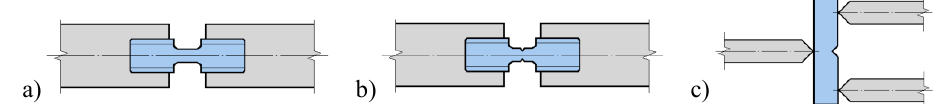
Fig. 1. Testing schemes of